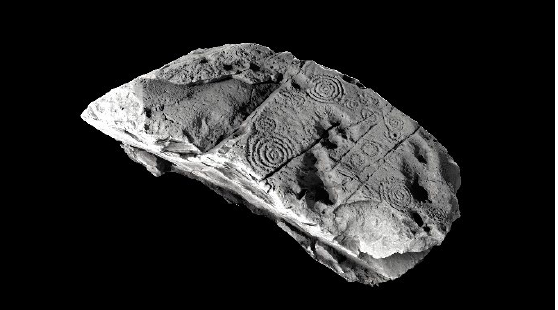
Figure 15. A rendered image of the K2 model generated in RealityCapture with procedurally generated texture.